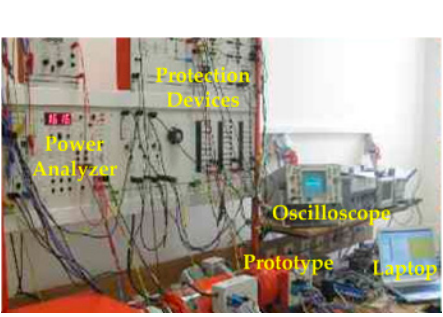
Figure 12. Laboratory implementation setup .